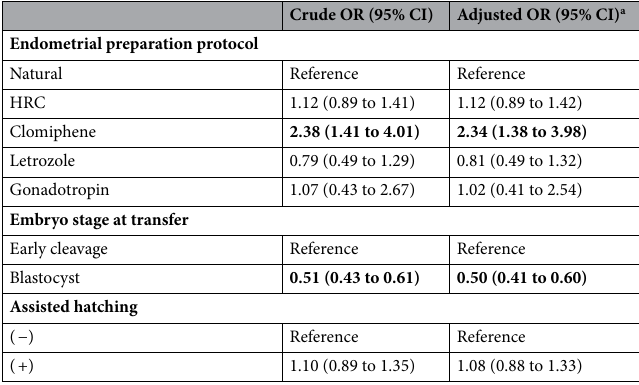
Table 2. Risk of ectopic pregnancy for ART treatment using frozen single embryo transfer cycles (n = 153,354). Significantly increased or reduced odds are indicated by boldface. CI confidence interval, HRC hormone replacement cycle, OR odds ratio. a Adjusted for maternal age, infertility diagnosis of tubal factor, endometriosis, male factor, other or unexplained and year.